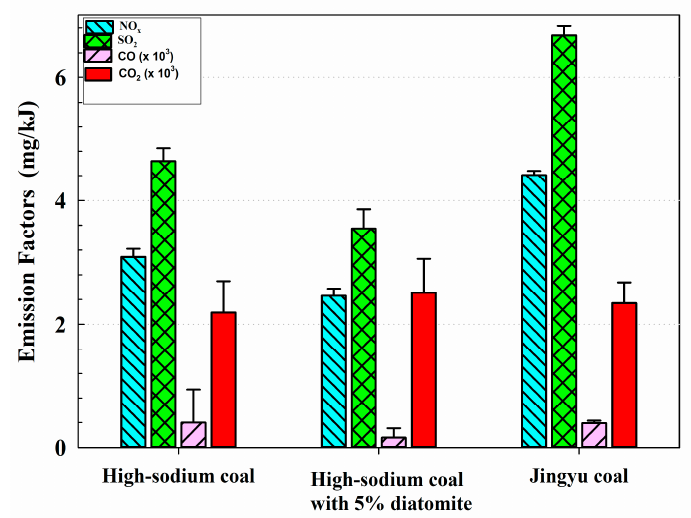
Figure 4. EFs of NO x , SO 2 , CO and CO 2 for tested coal samples.